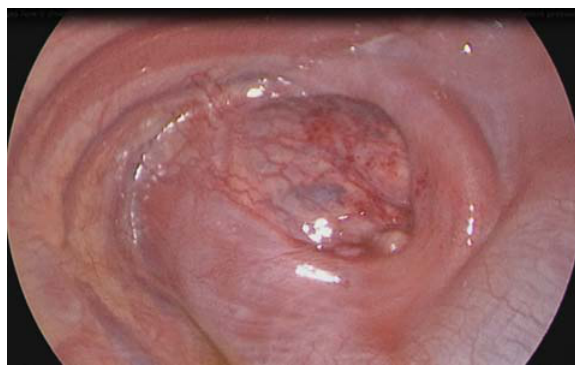
Fig. 1 Intrathoracic kidney along with mutiple loops of small bowel.